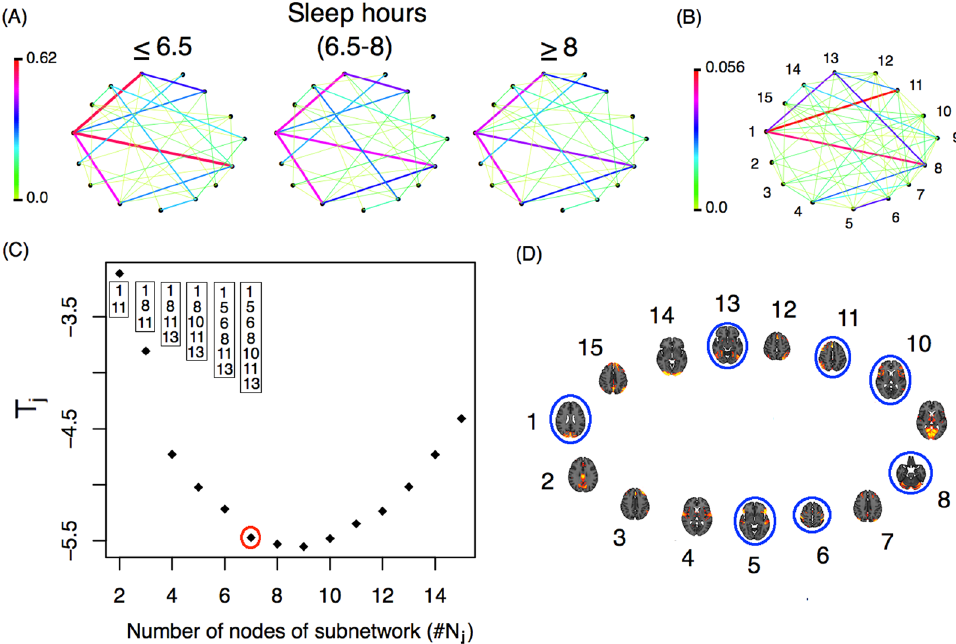
Figure 6. ( A ) Average network for each subgroup defined by hours of sleep ( B ) Weighted network with links that represent the differences among the subpopulation mean networks. ( C ) T j -statistic as a function of the number of nodes in each subnetwork ( j ). The nodes identified by the minimum T j are presented in the boxes, while the number of nodes identified by the procedure are represented with a red circle. ( D ) Nodes from the identified subnetwork are circled in blue. The nodes identified in ( D ) correspond to those in panel ( B